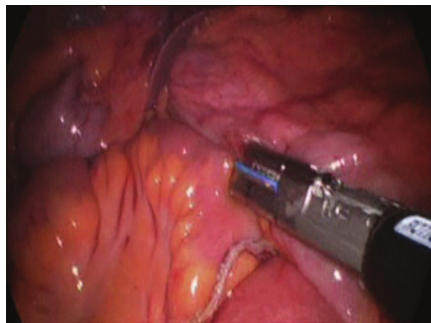
Figure 1: Intracorporeal anastomosis using an Endo Stapler with a blue cartridge.